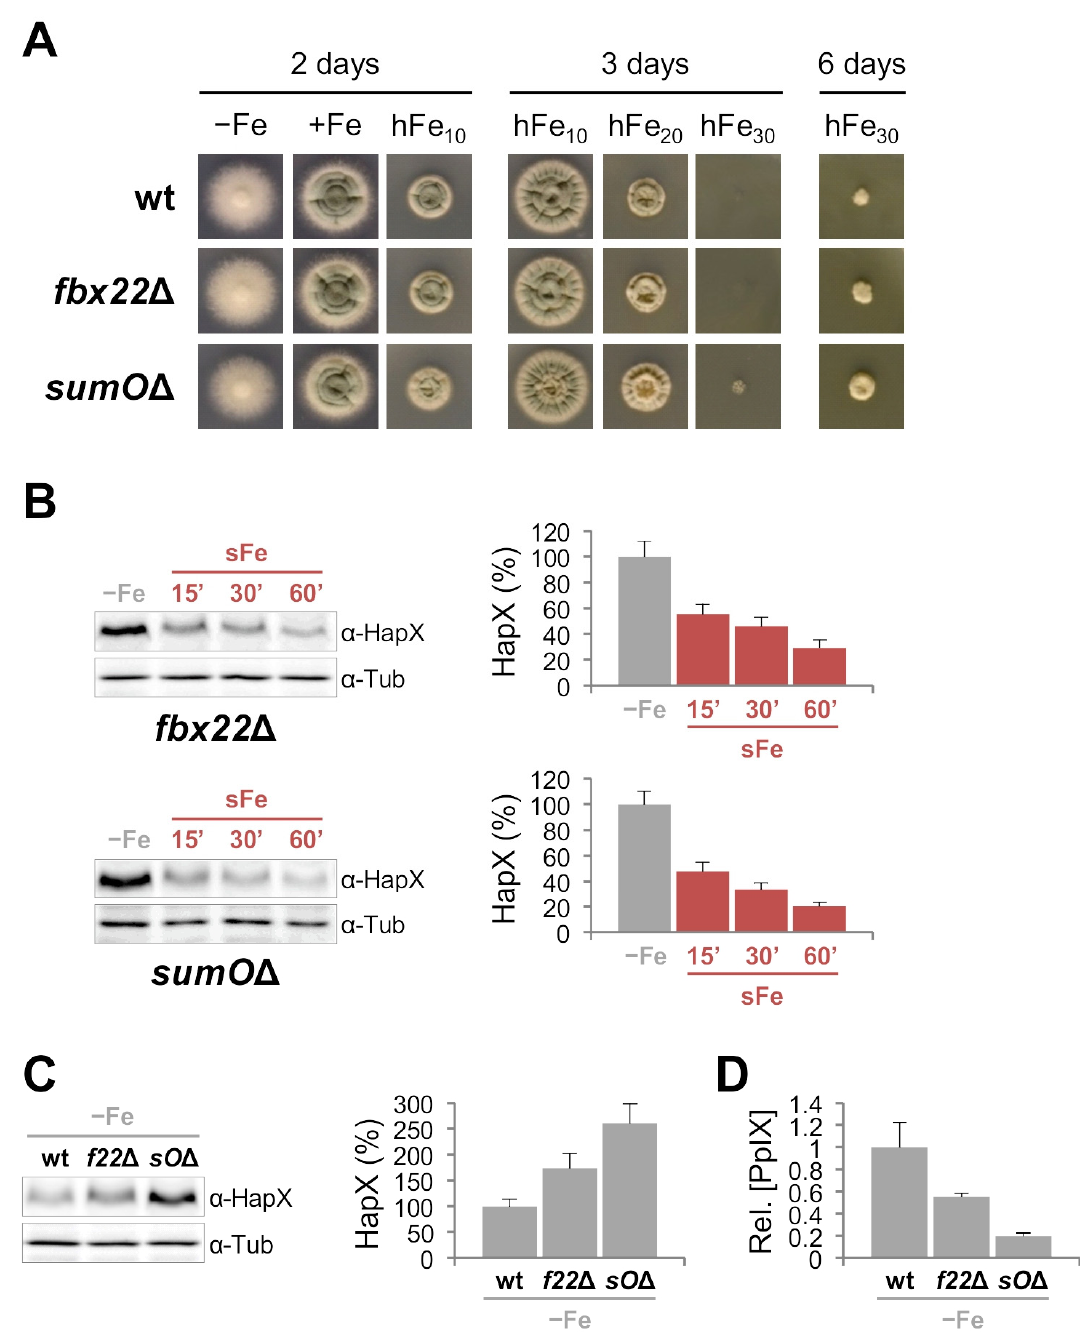
Figure 5. SumO and Fbx22 are important for iron resistance, regulation of HapX protein levels and heme biosynthesis. ( A ). Growth of the indicated strains on solid AMM − Fe (iron depletion), +Fe (30 µ M FeSO 4 ), and hFe (10, 20 or 30 mM FeSO 4 ). Plates were incubated for the indicated time periods at 37 ◦ C. Note that wild-type (wt) left panel is identical to that in Figure S3A. It is shown again here for clarity. ( B , C ). HapX quantification by Western blot analysis. Samples were obtained from the indicated strains grown under sFe conditions as in Figure 2B ( B ); or under − Fe conditions as in Figure 2A ( C ). Left panels: Representative Western blot analysis showing HapX protein levels. α -Tubulin was used as loading control. Right panels: Densitometric protein quantification. HapX protein levels were normalized to Tubulin and expressed relative to those in − Fe. ( D ). Quantification of PpIX in − Fe conditions. PpIX levels were normalized to the amount of total protein and expressed relative to those in the wild-type strain. Bars represent standard deviations from two independent biological experiments with two technical replicates